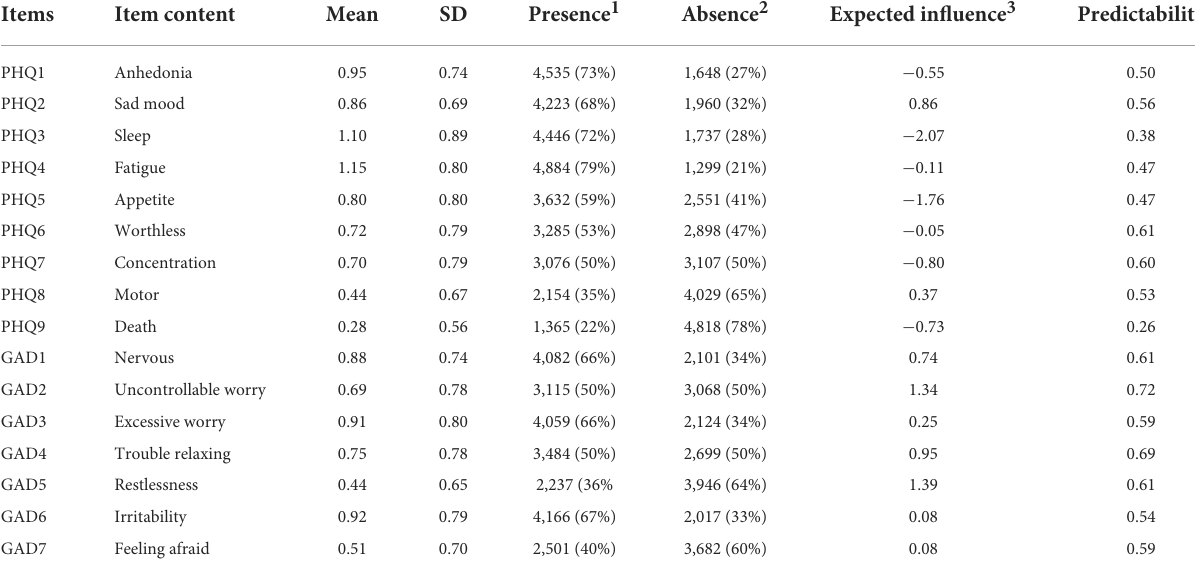
TABLE 2 Descriptive statistics of the PHQ-9 and GAD-7